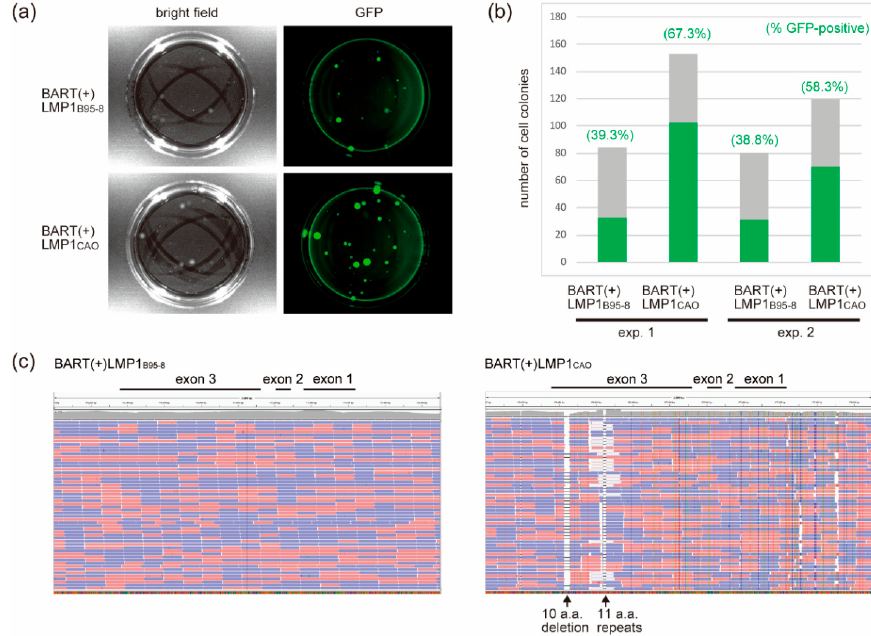
Figure 3. HEK293 cells stably transfected with EBV-BAC clones encoding various LMP1s. ( a ) Bright field images and GFP signals (in pseudo-color) are shown. Note that BART(+)LMP1 CAO generated more hygromycin-resistant/GFP-positive colonies than BART(+)LMP1 B95-8 . ( b ) The number of GFP-positive colonies was counted. The results of two independent experiments are shown. Numbers in parenthesis indicate the percentage of GFP-positive cell clones. ( c ) Nucleotide mismatches around the LMP1 locus of BART(+)LMP1 B95-8 and BART(+)LMP1 CAO were visualized using Integrative Genomics Viewer (IGV). The sequence of BART(+) LMP1 B95-8 [25] was used as a reference. Note that these BAC clones have different copy numbers of 11 a.a. repeats (Figure 1).